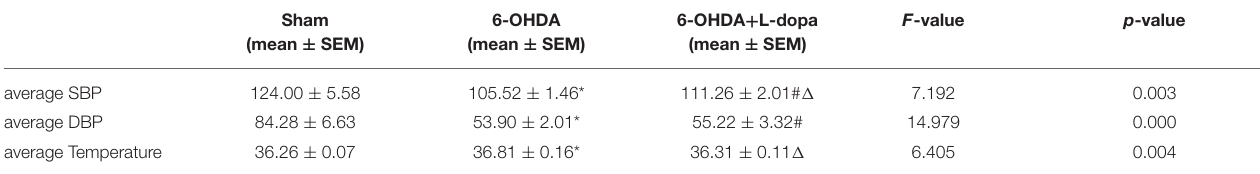
TABLE 1 | The average systolic blood pressure (SBP), diastolic blood pressure (DBP), and temperature over a 24-h period in the sham group, the 6-hydroxydopamine (6-OHDA)-lesioned group, and the 6-OHDA-lesioned + L-dopa group.